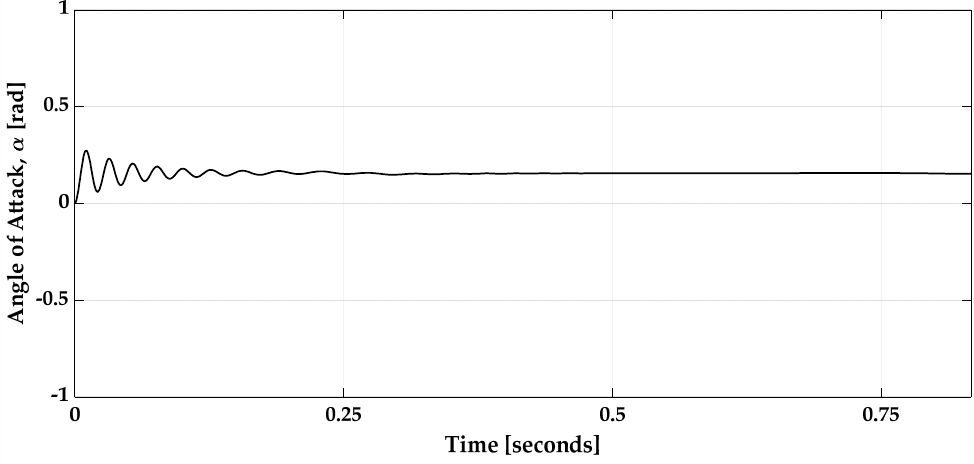
Figure 39. Angle of attack ( α ) versus time plot for longitudinal stability case.